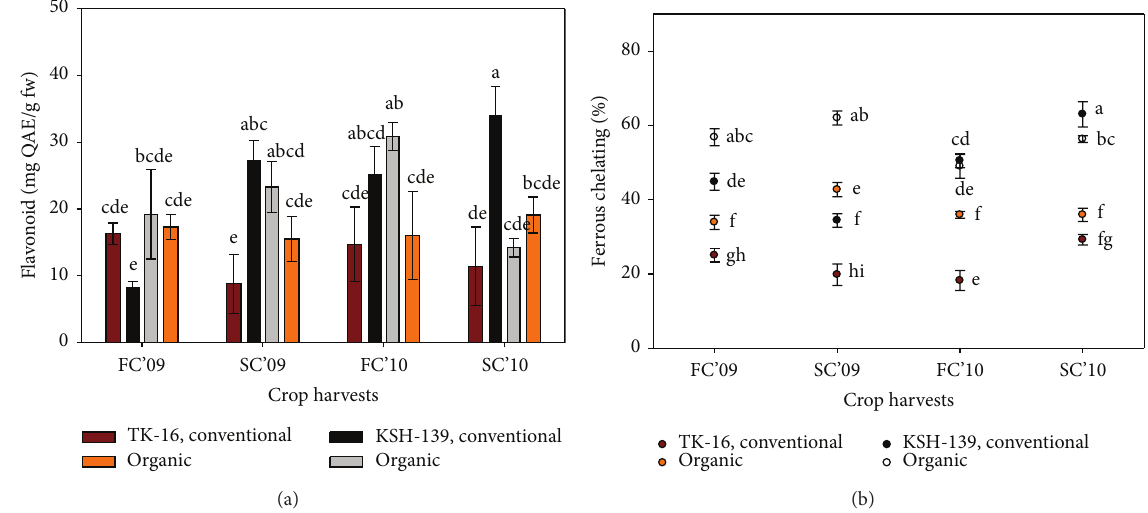
Figure 3: Influence of farming practices on (a) flavonoid content; and (b) ferrous chelating activity of two rice cultivars under different seasons. FC’09 = first crop (February–June) of 2009; SC’09 = second crop (August–November) of 2009; FC’10 = first crop (February–June) of 2010; SC’10 = second crop (August–November) of 2010. Values with different letters are significantly different ( ± S.E.) 𝑃 ≤ 0.05